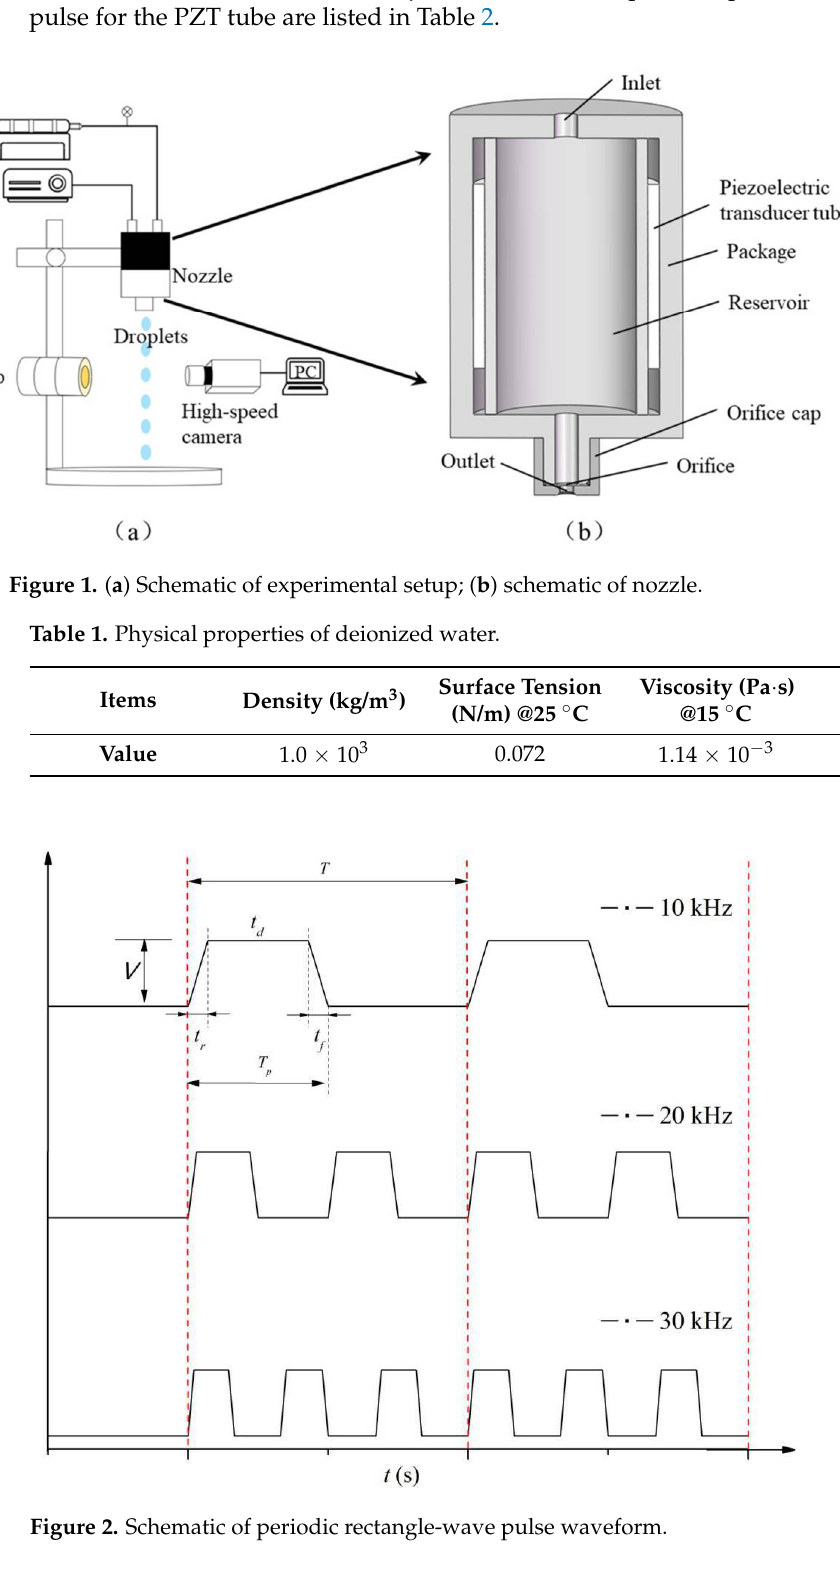
Figure 2. Schematic of periodic rectangle-wave pulse waveform.